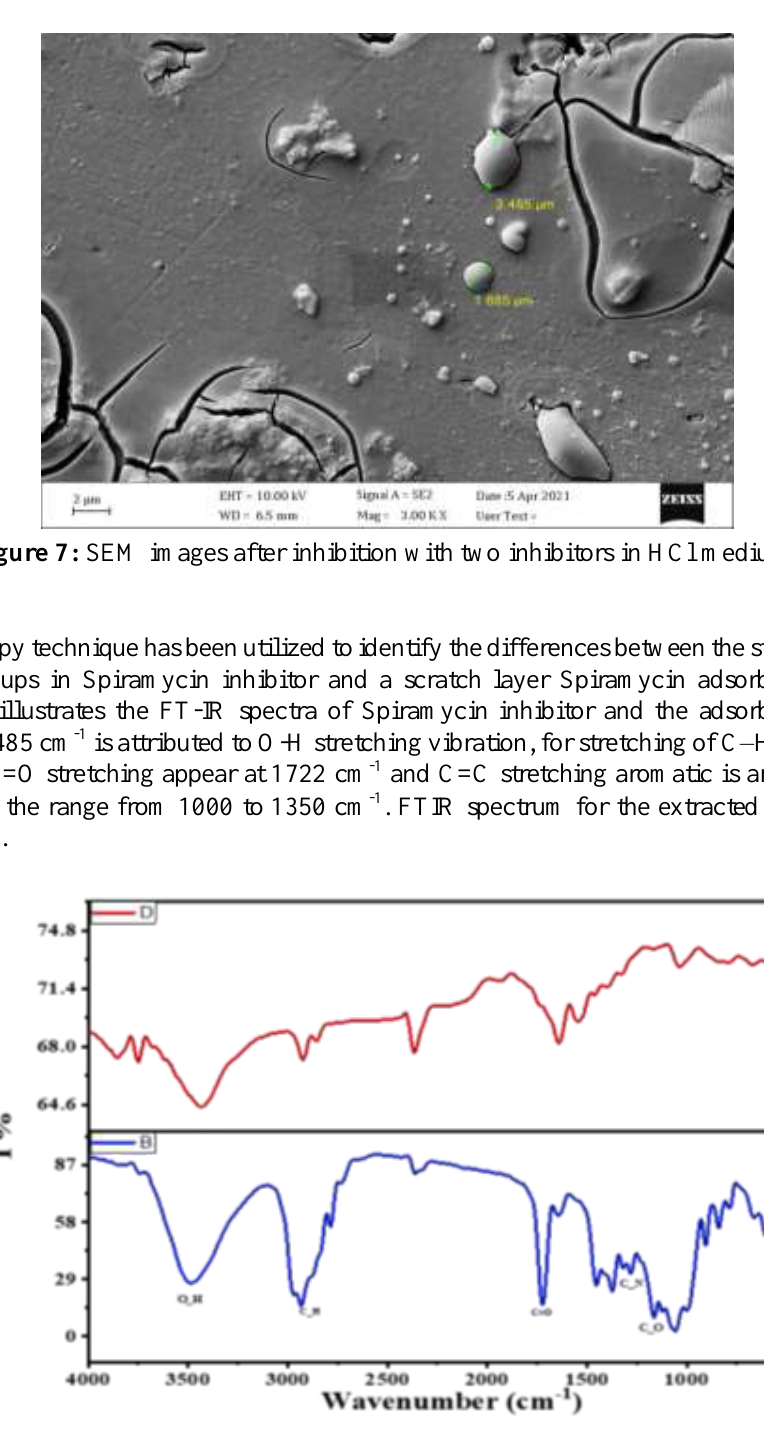
Figure 8: FTIR spectra of Spiramycin (blue line) and film formed after adsorption on aluminum surface (red line 200